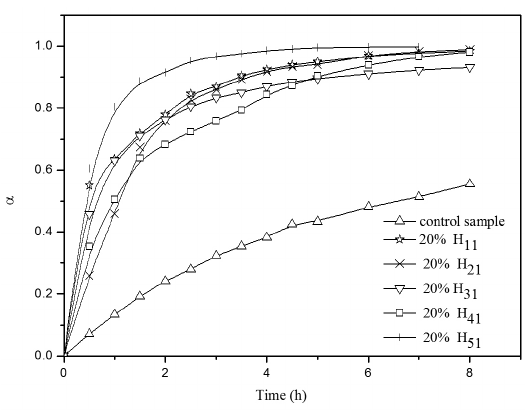
Figure 4. Conversion-time curves for the control sample and H-IPNs with 20 wt% of different generations of AHPE.